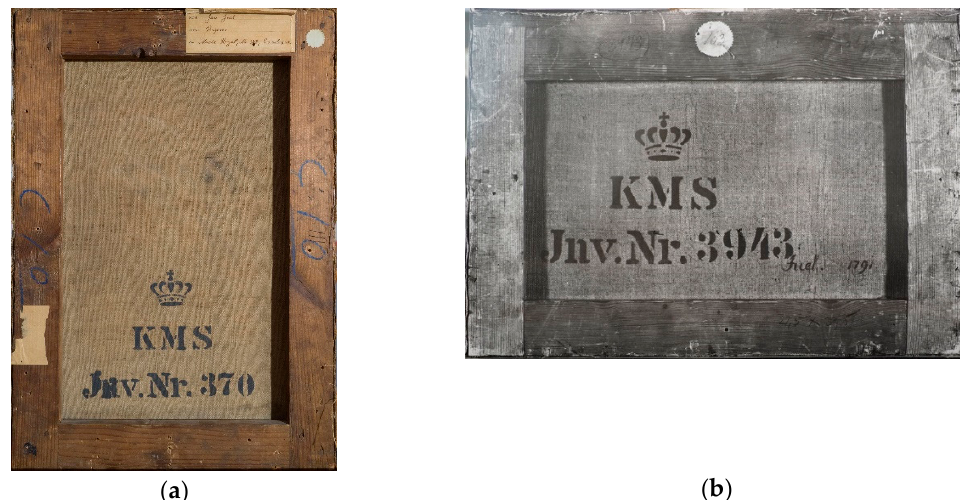
Figure 1. Original late-eighteenth-century rectangular strainers in paintings by Jens Juel: ( a ) the verso of The Roman Dwarf Francesco Ravai, called Bajocco, 1773 – 1776 (1775), National Gallery of Denmark (SMK), KMS370, Oil on canvas, 48.5 × 34 cm; ( b ) the verso of Flowers and Fruit on a Table , 1791, National Gallery of Denmark (SMK), KMS3943, oil on canvas, 27.5 × 39.5. Strainer now replaced. Image from SMK archives. Table 1. Overview of information regarding original strainers of the twenty-two paintings by Jens Juel included in this study. Where marked in grey, the painting remains mounted on the original strainer.